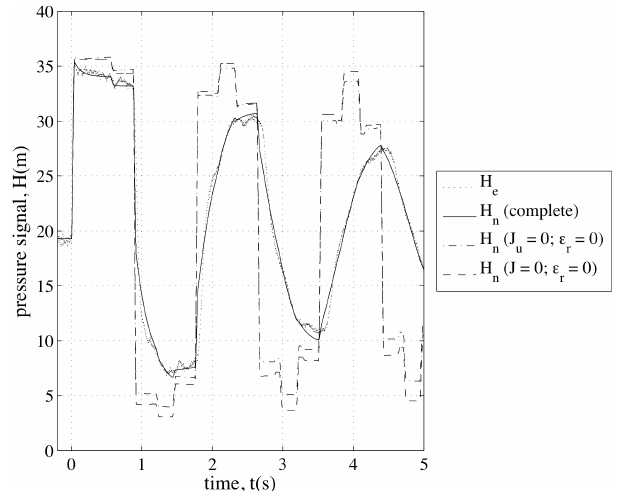
Figure 7. Damaged pipe with leak no. 1 ( Q 0 = 2.90 l/s): experimental pressure signal at section M vs. numerical model simulations.